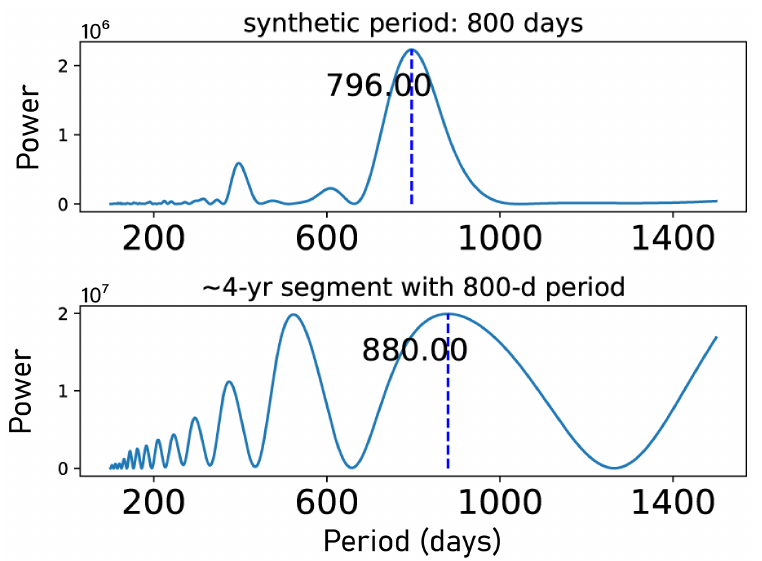
Figure 8. Power spectrum of the synthetic data points which are depicted in Figure 7. The upper panel depicts the periodogram of the total synthetic light curve. The lower panel depicts the periodogram of an ∼ 4 years (1470 days exactly) segment of the synthetic light curve. The peaks of both panels are marked by vertical dotted lines, and the positions of the peaks are